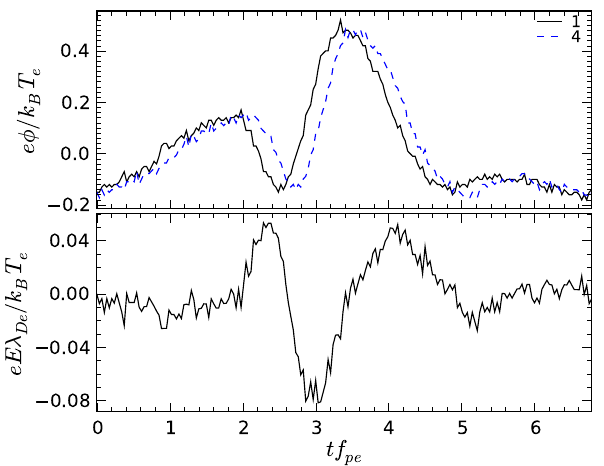
Fig. 3. A structure with a tripolar electric field.